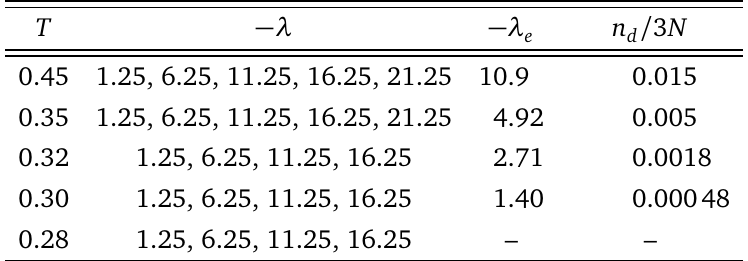
Table 4: Eigenvalues used to compute the average in Eq. (7), mobility edge λ fraction of the delocalized unstable modes n for N = 1000